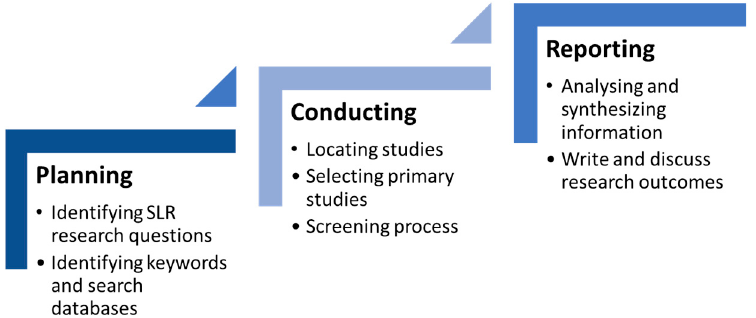
Figure 2. Systematic literature review phases.